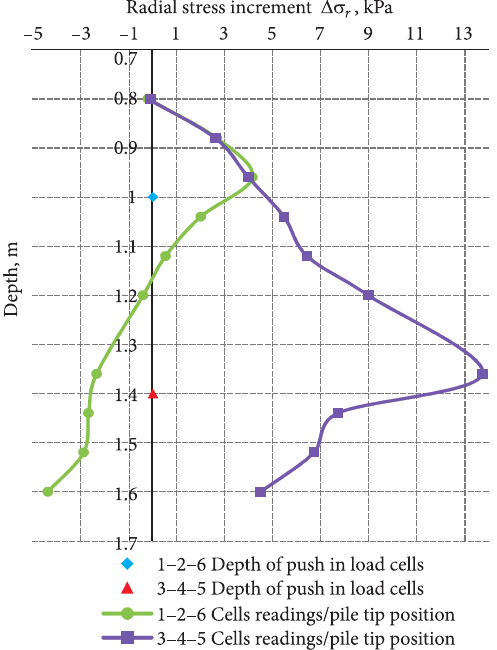
fig. 16. Results of 2 nd model pile test when pile push in was being performed up to 1.6 m